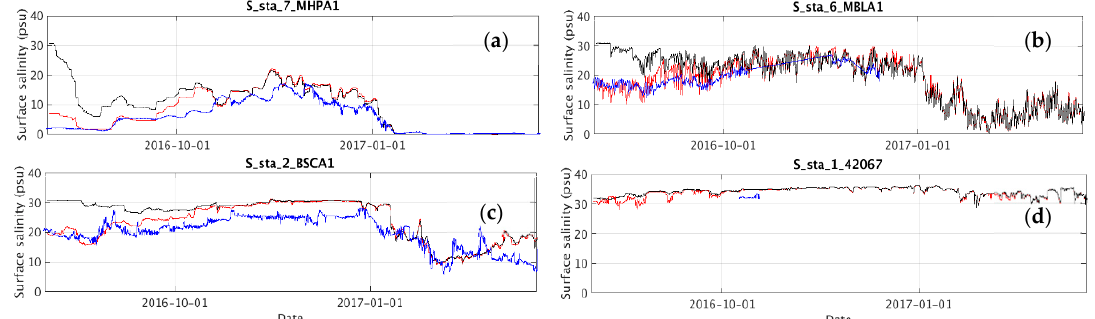
Figure 18. Comparison of the observed (blue lines) and the hindcast (black and red lines) salinity time series at stations ( a ) MHPA1, ( b ) MBLA1 and ( c ) BSCA1, and ( d ) 42067. The two model time series correspond to initial salinity conditions populated with G-RTOFS (black lines) and NGOFS (red lines), respectively.